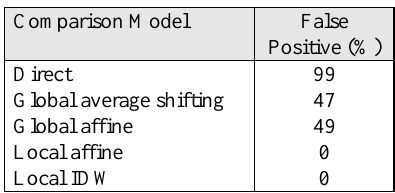
Table 2. Comparison of false positive errors using all five models in a desert